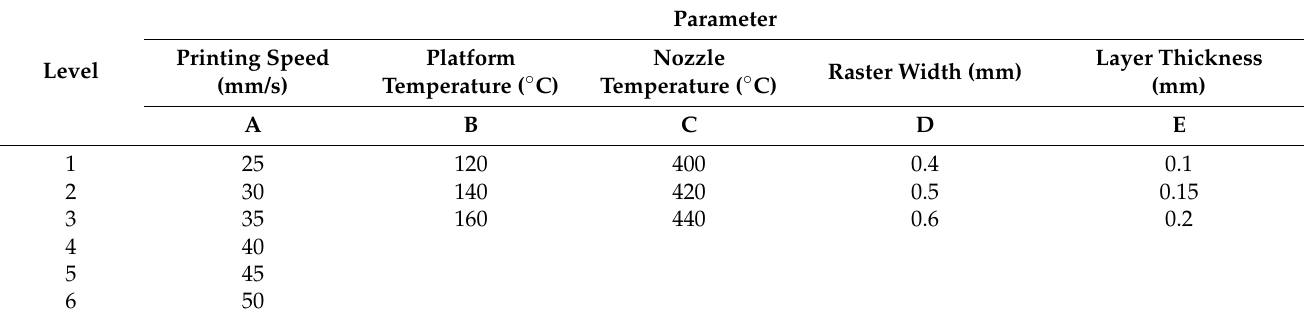
Table 3. Factors and Levels of the Orthogonal